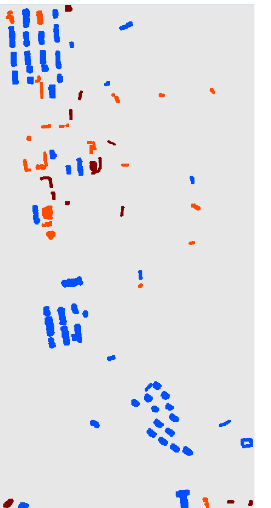
Figure 3. Per-year building changes (YBC) reference map: ( Blue : built before 2009; Orange: built before January 2011; Red: built before May 2011).